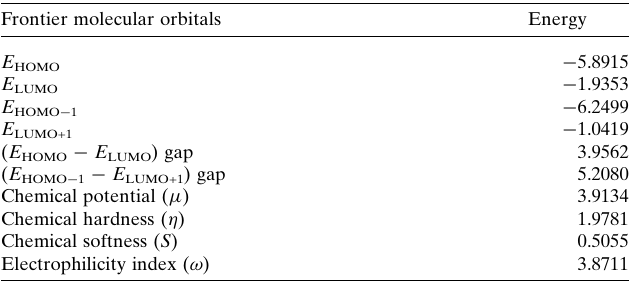
Table 2 The global reactivity descriptors (eV) of the title compound. Frontier molecular orbitals